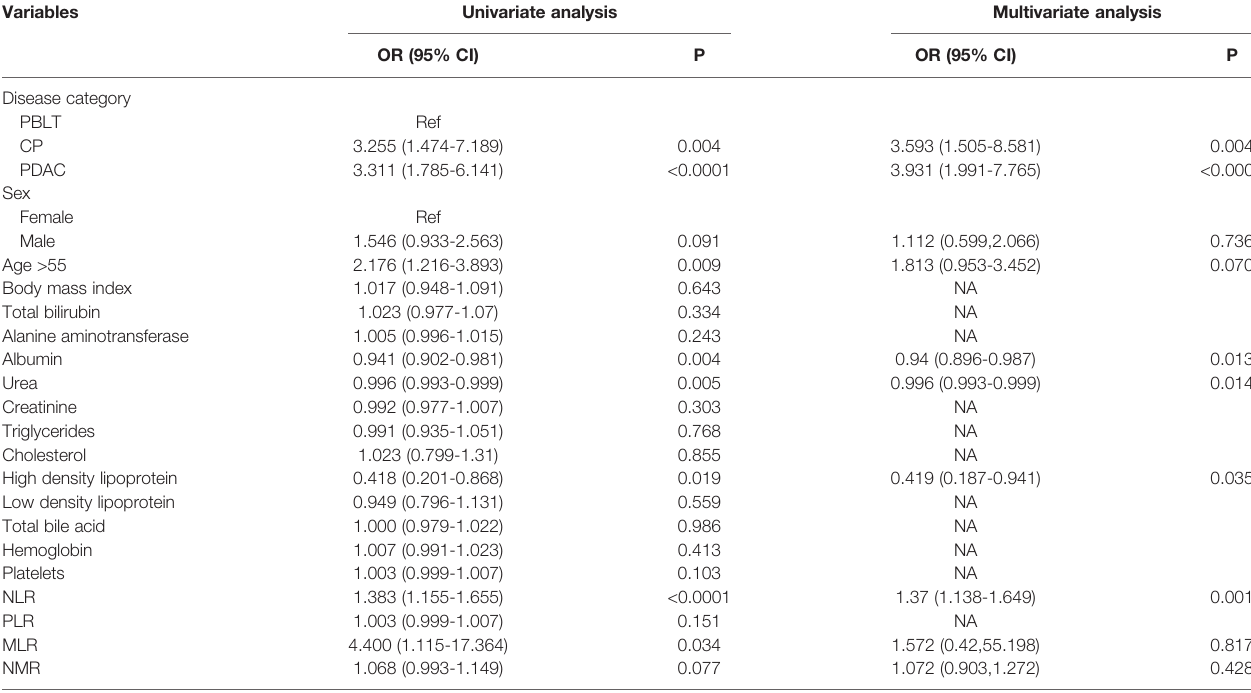
TABLE 2 | Risk factors for diabetes by univariate and multivariate logistic regression